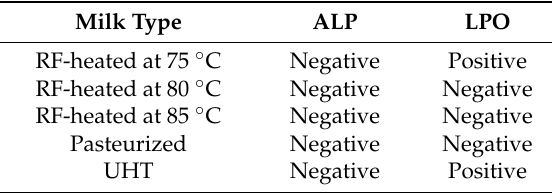
Table 2. Results for ALP and LPO tests, and comparison with pasteurized and UHT